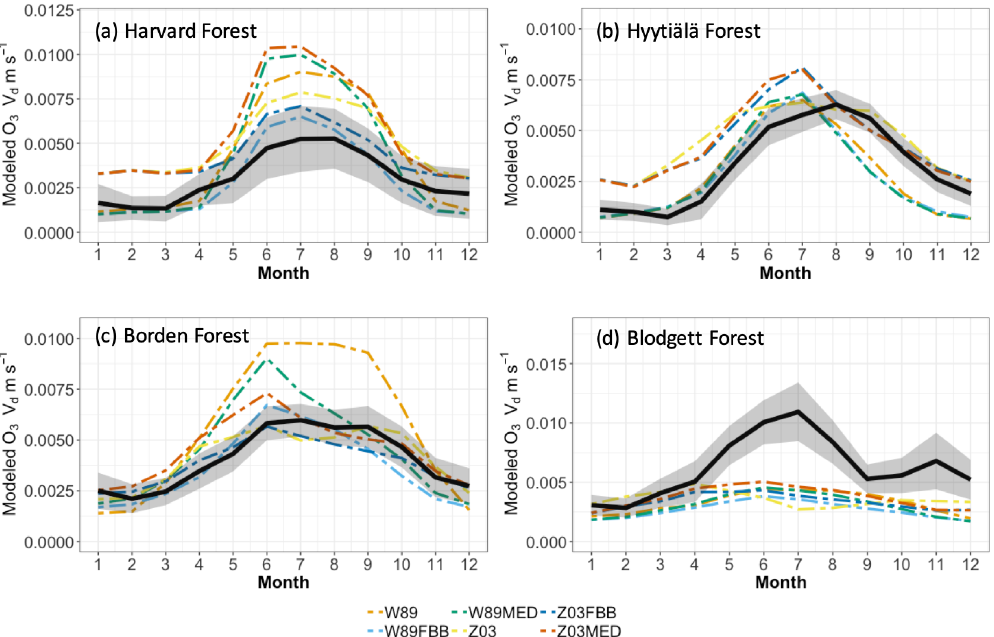
Figure 2. Average monthly daytime (local time 06:00–18:00) ozone dry deposition velocity. Black solid lines indicate observed average monthly v d . Shaded envelope shows standard deviation of observed summertime average monthly daytime v d . Colored lines indicate simu- lated average monthly v d using different dry deposition